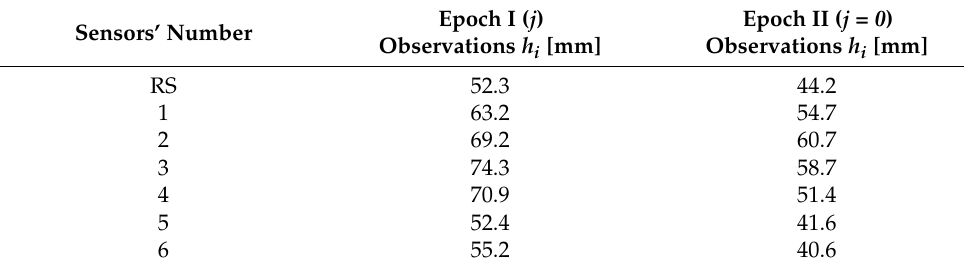
Table 1. The results h obtained from epoch I and epoch